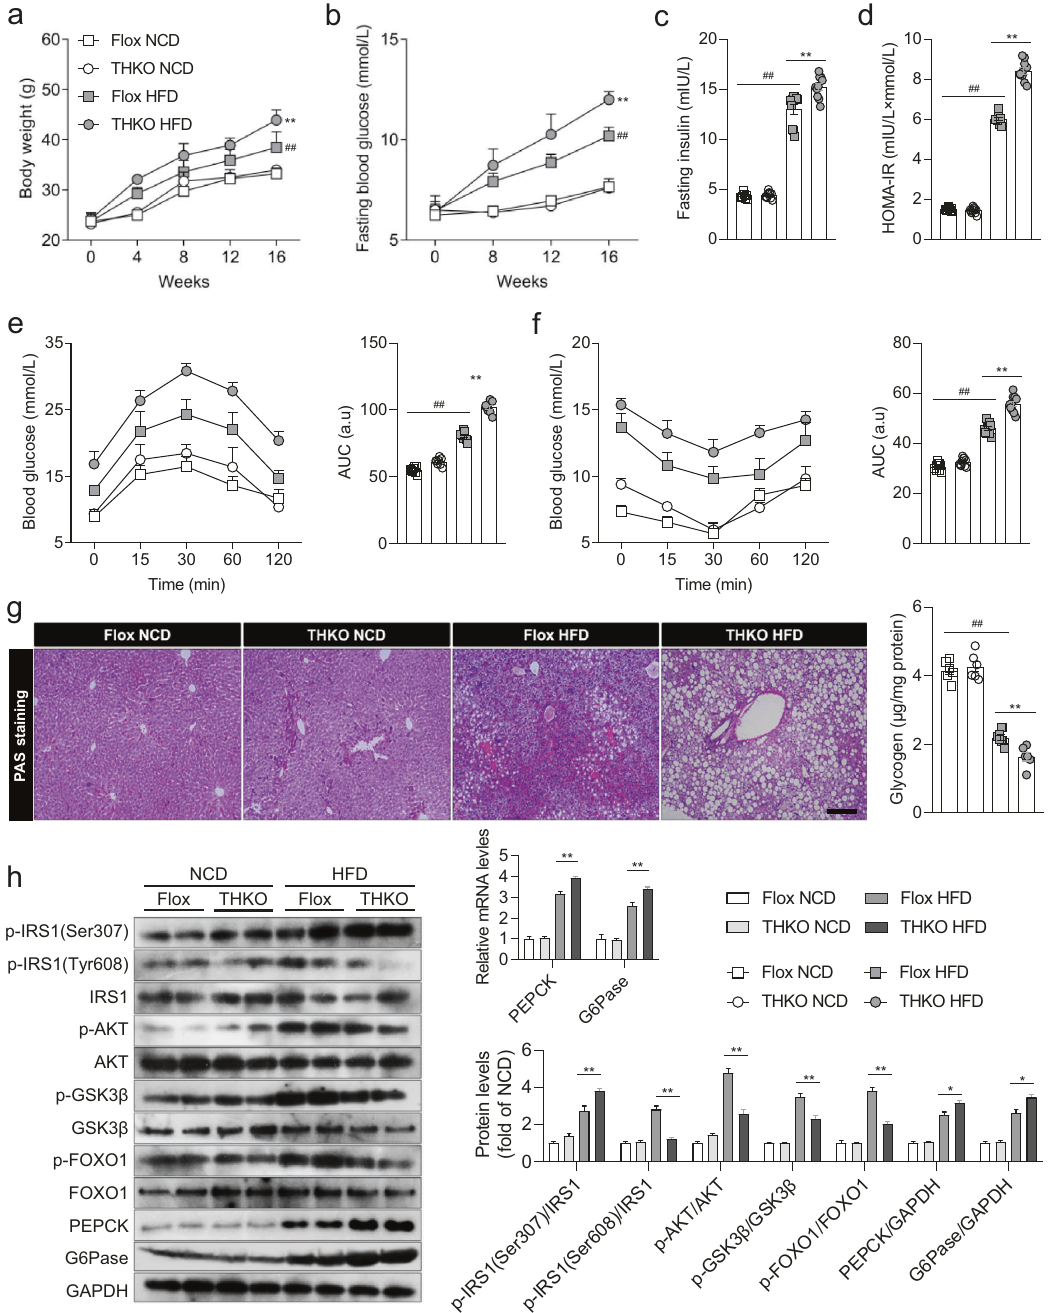
Fig. 2 Hepatocyte-speci fi c Trim31 deletion aggravates HFD-triggered pathological phenotypes of insulin resistance. a , b Body weight records ( a ) and fasting blood glucose levels ( b ) of Trim31 fl ox (Flox) and hepatocyte-speci fi c Trim31 deletion (THKO) mice during 16 weeks of NCD or HFD administration ( n = 15 mice) (** P < 0.01 vs. Flox HFD groups, ## P < 0.01 vs. Flox NCD groups). c , d Fasting insulin levels ( c ) and corresponding HOMA- IR index ( d ) of Flox and THKO mice at the last week of NCD or HFD feeding ( n = 10 mice) (** P < 0.01 vs. Flox HFD groups, ## P < 0.01 vs. Flox NCD groups). e , f Records for the glucose tolerance test (GTT) ( e ) and insulin tolerance test (ITT) ( f ) in th e Flox and THKO mice at the last week of NCD or HFD ingestion; a.u, arbitrary unit ( n = 10 mice) (** P < 0.01 vs. Flox HFD groups, ## P < 0.01 vs . Flox NCD groups). g Representative images of Periodic Acid-Schiff stain (PAS)-stained pathological section for glycogen storage changes in the liver samples from the Flox and THKO mice (magni fi cation, ×100; n = 6 images per group for each staining) (** P < 0.01 vs. Flox HFD groups, ## P < 0.01 vs. Flox NCD groups). h Representative immunoblotting bands for expression alterations of total amounts and phosphorylated forms of critical indicators involved in insulin signaling, including IRS1, AKT, GSK3 β , FOXO1, PEPCK, and G6Pase, in the liver of Flox and THKO mice after HFD feeding for 16 weeks ( n = 4 per experiment) (* P < 0.05 and ** P < 0.01 vs. Flox HFD groups, ## P < 0.01 vs. Flox NCD groups). The GAPDH was used as a loading control. Data are expressed as mean ± SEM. The